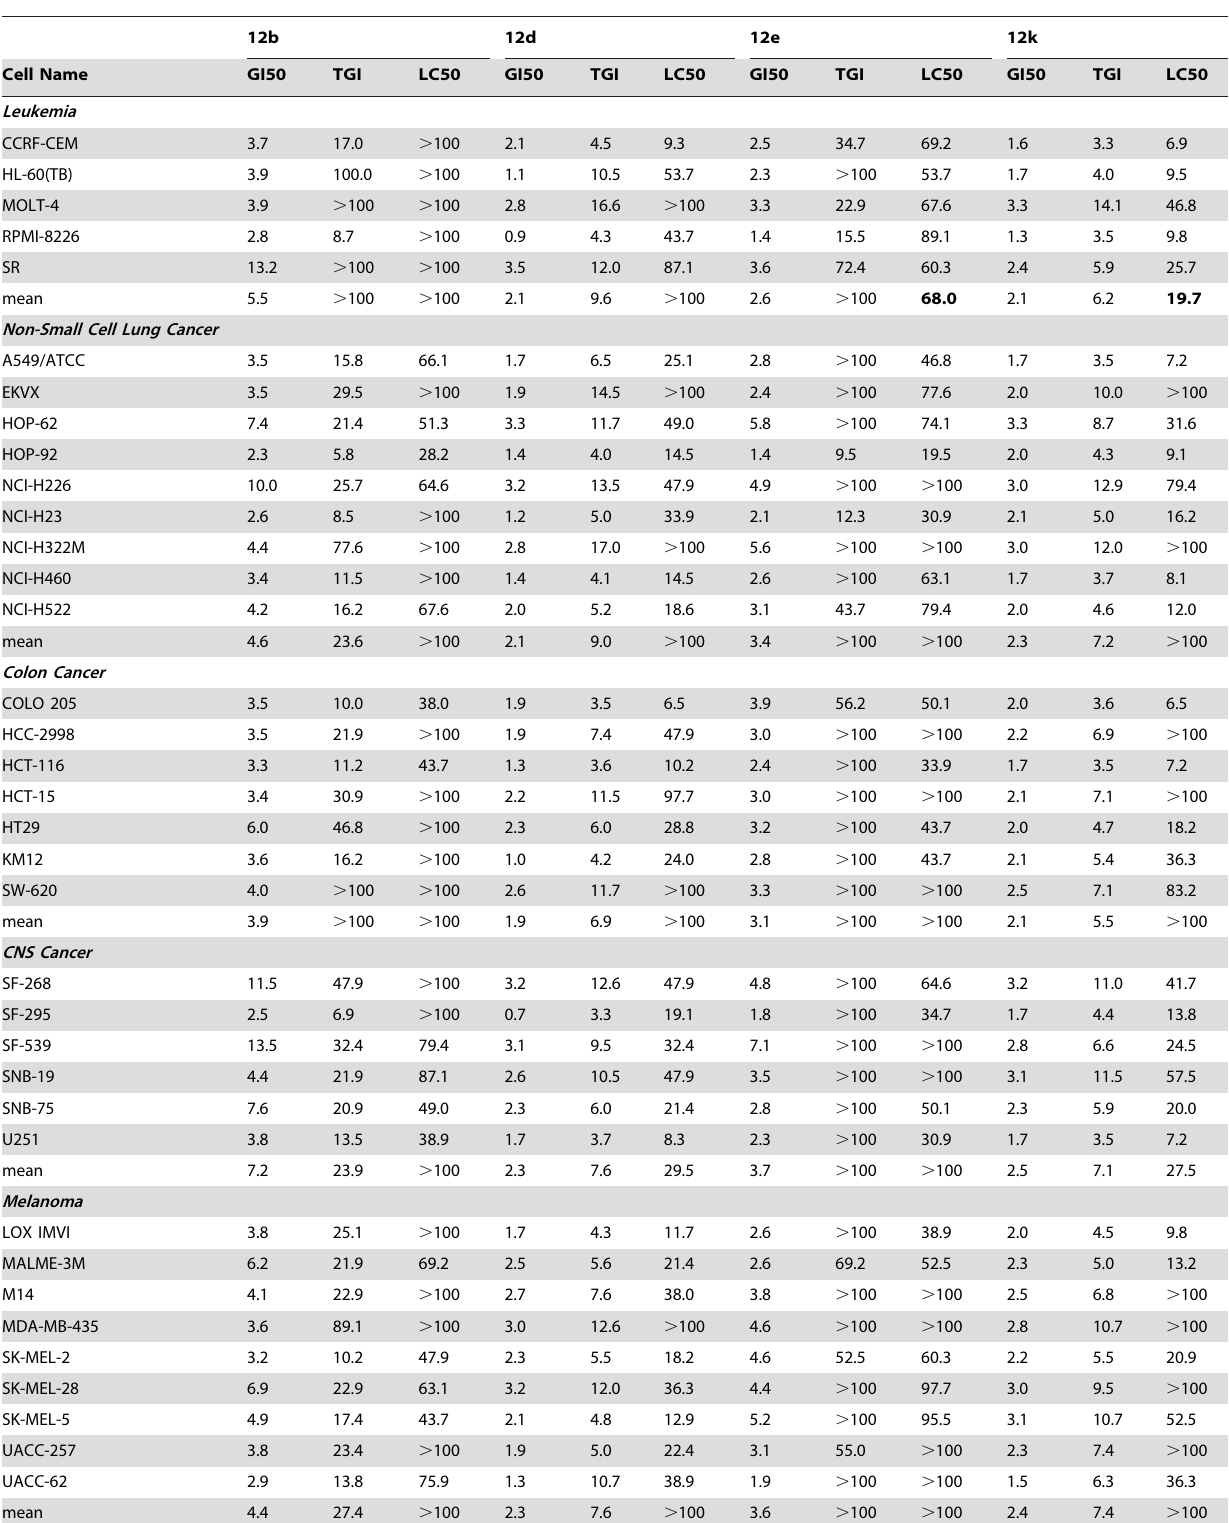
Table 4. GI 50 , TGI and LD 50 values mean and Full Panel GI 50 Mean Graph Mid-Point (MG-MID) for the selected four compounds (12b, 12d, 12e and